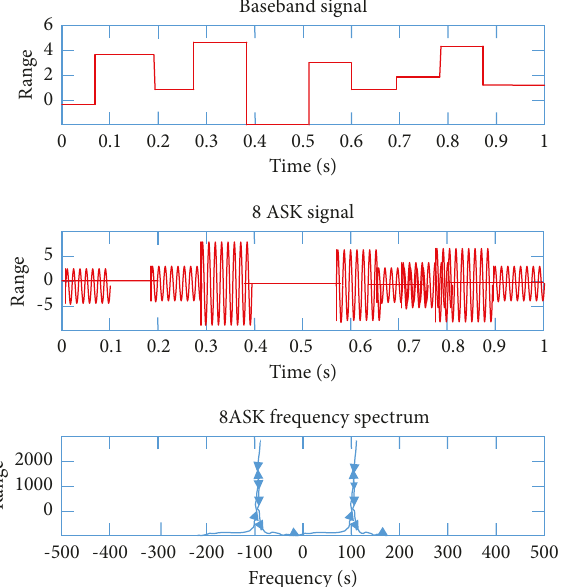
Figure 3: 8ASK time-domain waveform and spectrum. Figure 4: 2PSK time-domain waveform and spectrum.